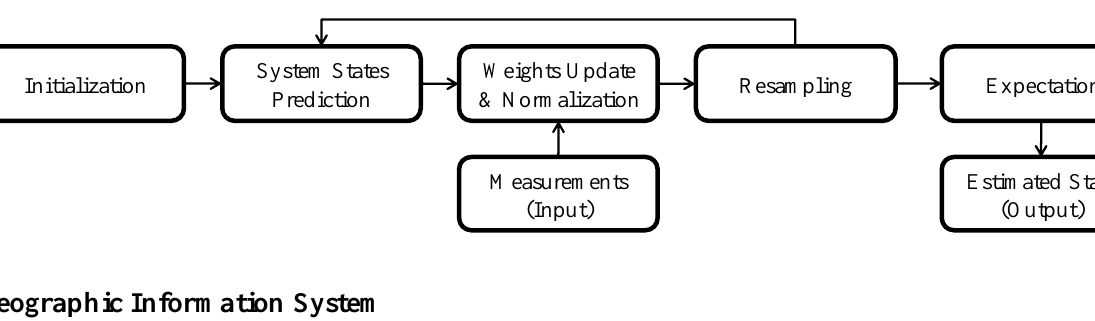
Figure 6. The flowchart of the SIR particle